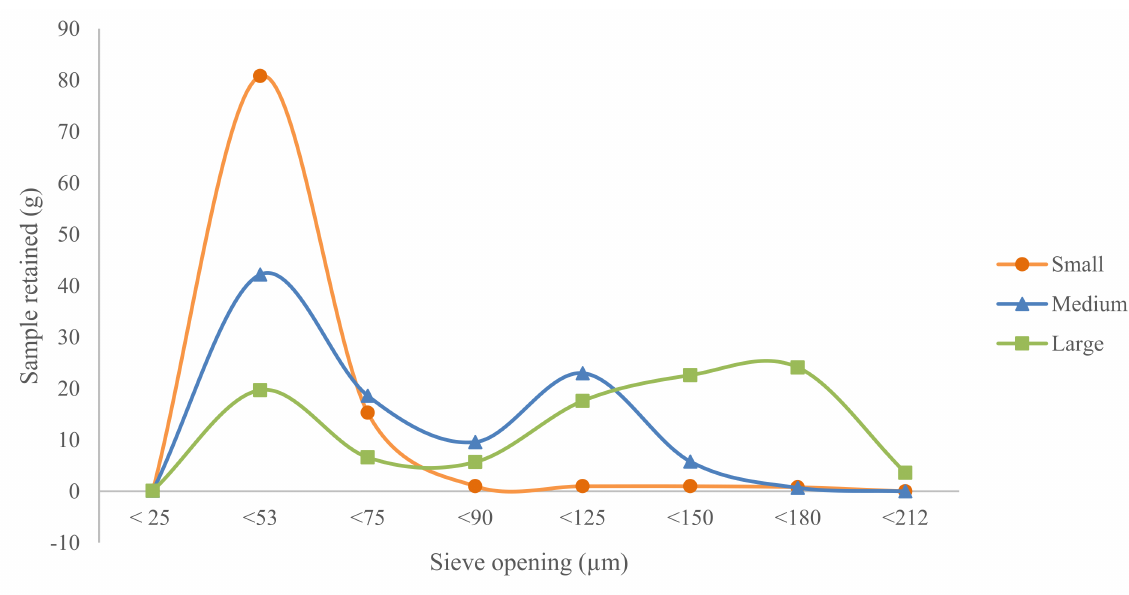
Figure 4. Particle size distribution of small, medium, and large yellow pea